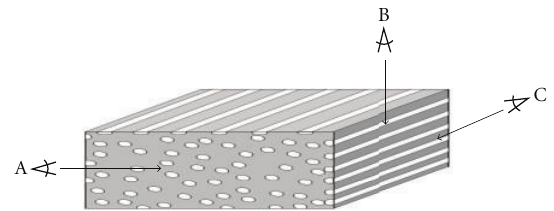
Figure 2: Schematic and simplified picture of FRC specimen show- ing fibers in di ff erent orientation planes: (A) fibers running trans- versely; (B) fibers running in-plane (perpendicular); (C) Fibers running in-plane